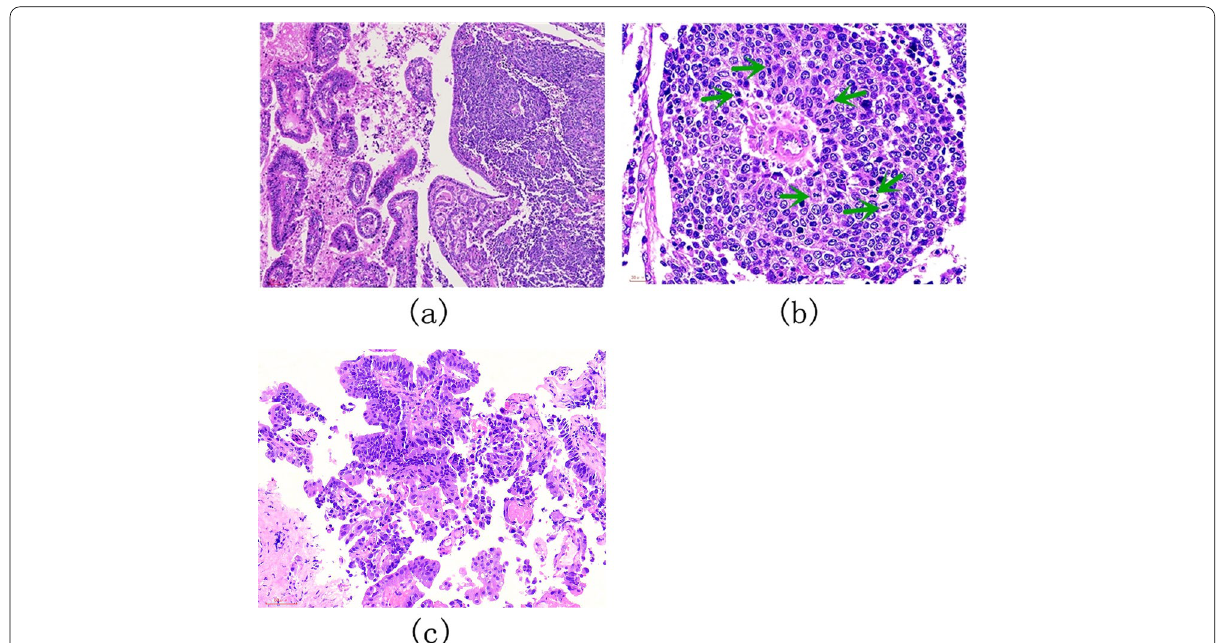
Fig. 2 Case 1: Histological findings of MiNEN in the gallbladder by hematoxylin and eosin (HE) staining. a Two components, LCNEC (right) and papillary adenocarcinoma (left) showed mixed composition and solid sheet distribution, with an obvious transitional zone between the two tissues. Magnification, 100. b large cells arranged in solid sheets, with vesicular nuclei and abundant eosinophilic cytoplasm, and tumor cells had × large-sized densely stained round to oval nuclei, in some cells visible nucleoli, high mitotic index (arrows), and focal tumoral necrosis consistent with LCNEC were showed. Magnification, 400. c Metastatic lesion of the bile duct showing well-differentiated papillary adenocarcinoma. ×